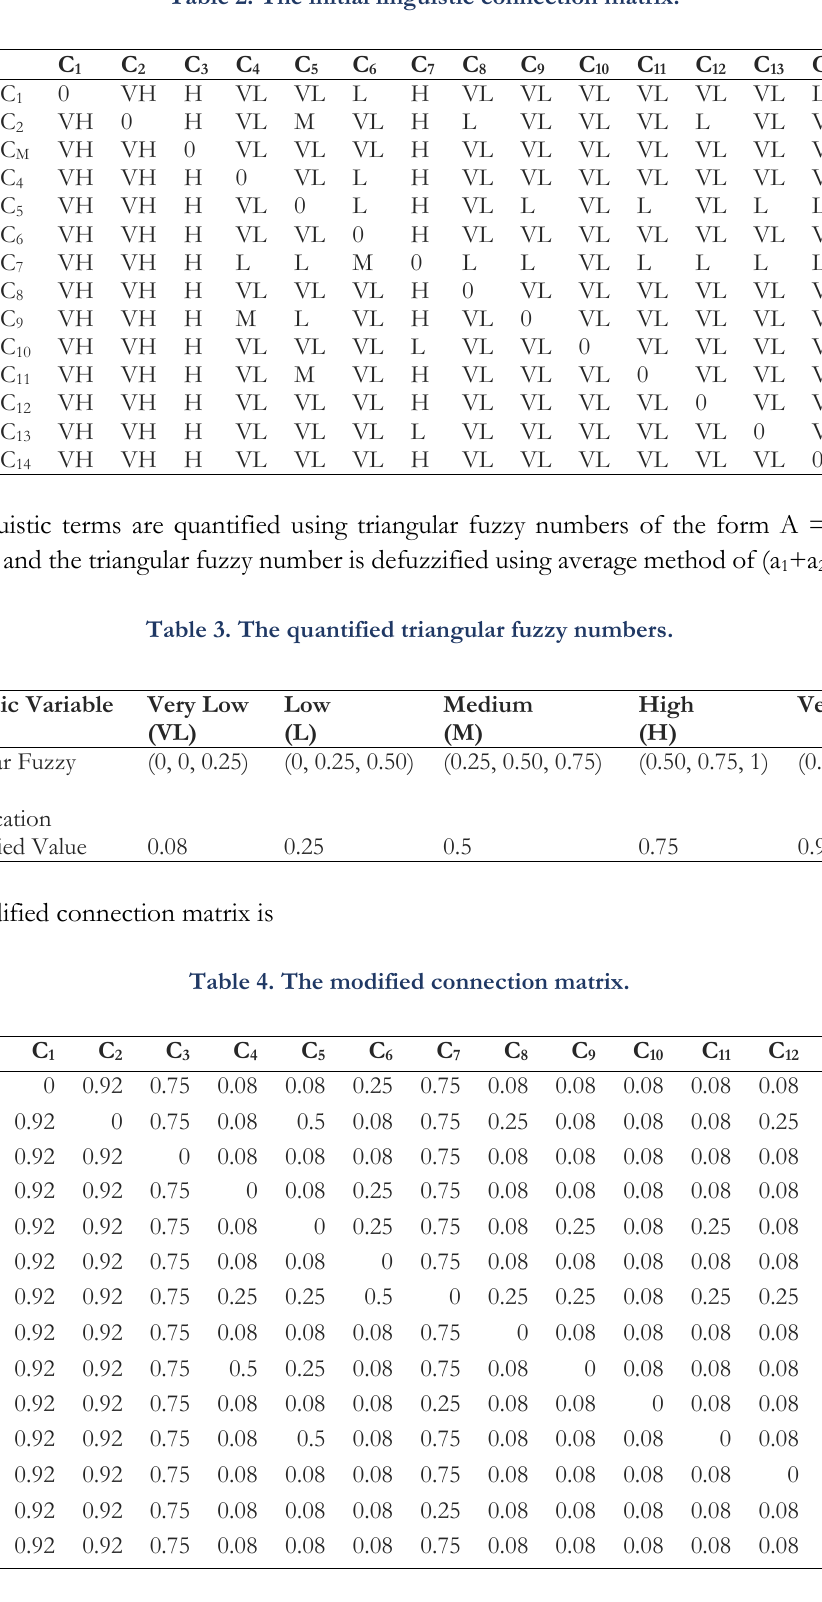
Table 2. The initial linguistic connection matrix.